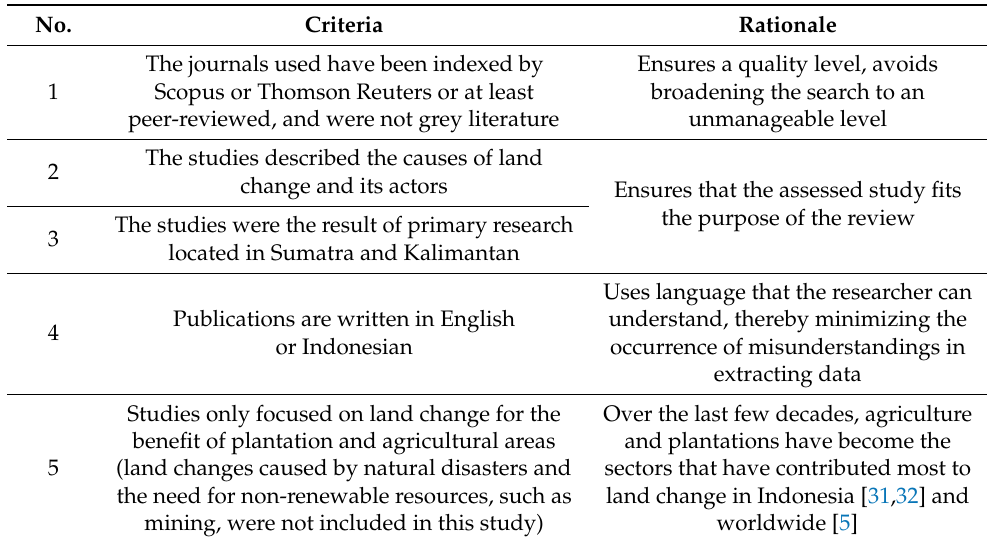
Table 1. Inclusion criteria for studies included in systematic